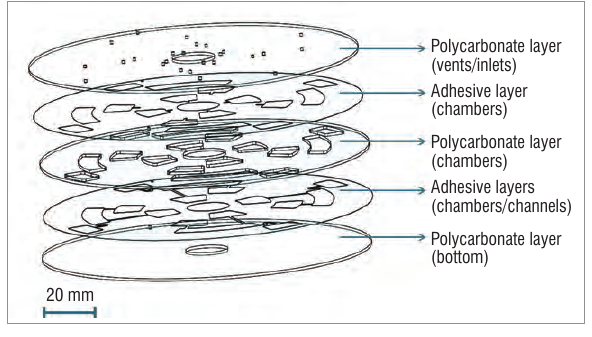
Illustration of the multilayered centrifugal microfluidic disc device. The blood simulant solution was made from 10 mg dry baker’s yeast in 100 mL deionised water to yield a similar concentration of cells to that of white blood cells found in a human blood sample. The staining reagent was a 2% acetic acid solution with 1 mg crystal violet in 100 mL deionised water – a standard white blood cell reagent commonly used to lyse red blood cells and stain the nuclei of white blood cells for manual white blood cell counting. Approximately 70 µL of both the staining solution and the yeast solution were pipetted into chambers 1 and 2, respectively, via the inlet holes on top of the chamber openings (Figure 3). The microfluidic disc was then placed on the motor spindle of the centrifugal microfluidic platform set- up for testing of the fluid functions. The motor was controlled through the SmartMotor Interface software issued with the motor hardware. The motor was set to operate at a constant velocity to enable continuous rotation of the disc on the motor spindle. For each change in the speed of the rotating disc, an acceleration